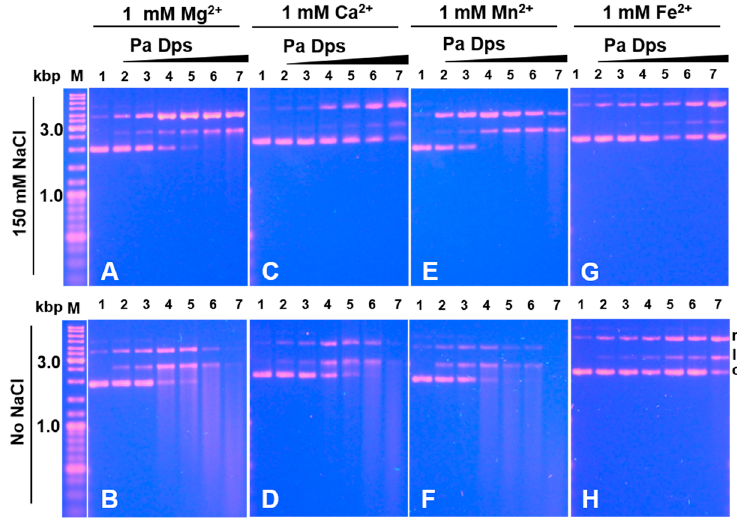
Figure 9. Pa Dps cleaves DNA. pUC18 plasmid DNA (8.6 nM) was incubated (1 h, 35 °C) with distinct concentrations of Pa Dps in 75 mM Tris pH 7.5 containing 150 mM NaCl and 1 mM ( A ) Mg 2+ , ( C ) Ca 2+ , ( E ) Mn 2+ , and ( G ) Fe 2+ , and in 75 mM Tris pH 7.5 containing 1mM ( B ) Mg 2+ , ( D ) Ca 2+ , ( F ) Mn 2+ , and ( H ) Fe 2+ . Samples were separated using 1% agarose gels (TBE buffer, 80V 105 min) and stained with ethidium bromide. Lane 1 = DNA, lanes 2–7, respectively, Pa Dps:DNA mole ratio 5, 10, 50, 100, 200, and 400. Lane M = DNA electrophoresis ladder. Circular plasmid DNA is denoted by c, relaxed (nicked) DNA by r, and linear DNA by l. In experiments involving iron, Fe 2+ , Pa Dps, and DNA were incubated in an anaerobic glove box. Control experiments with bovine serum albumin (BSA) in the presence of Mg 2+ show that the plasmid DNA remains intact (Figure S6).